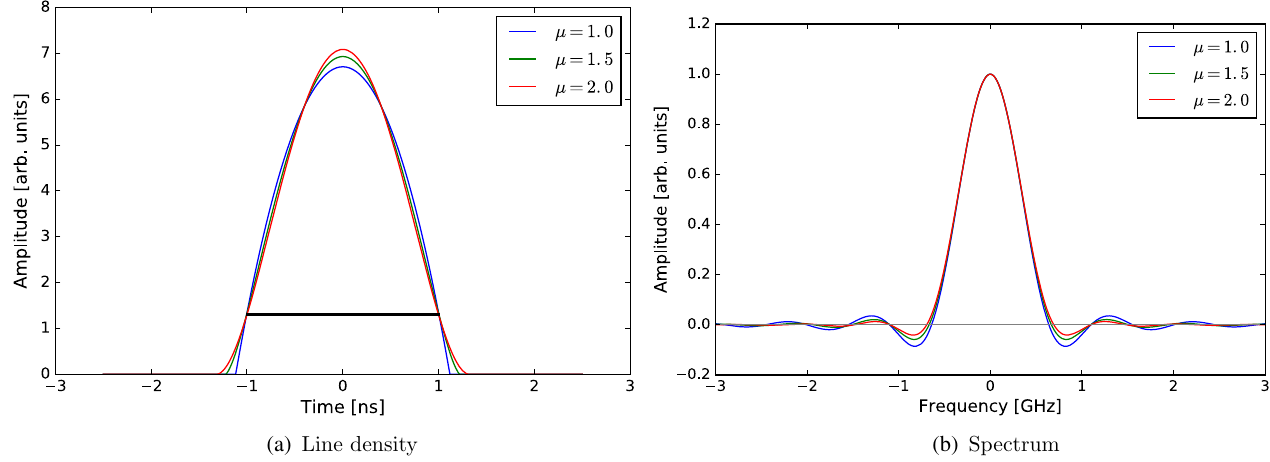
. The black line rms